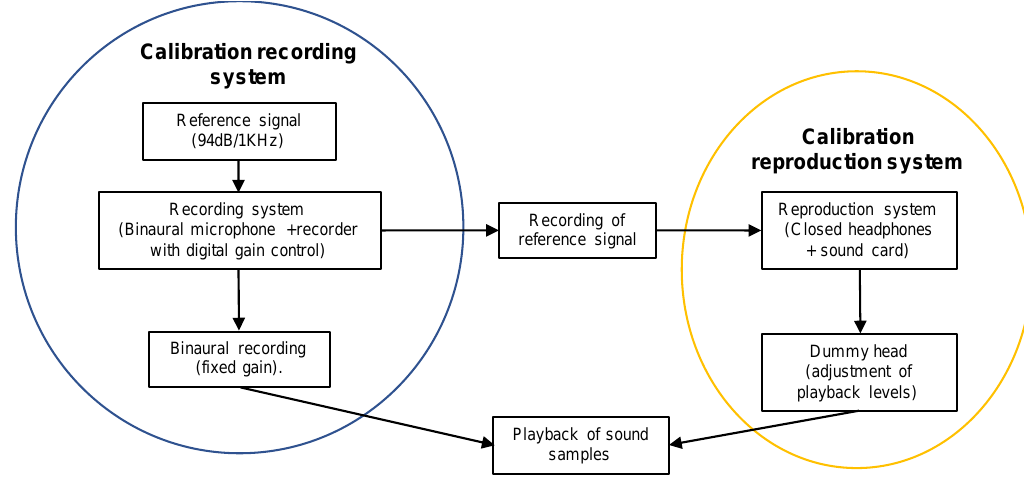
Figure 2: Calibration process diagram for the recording and reproduction of the sound